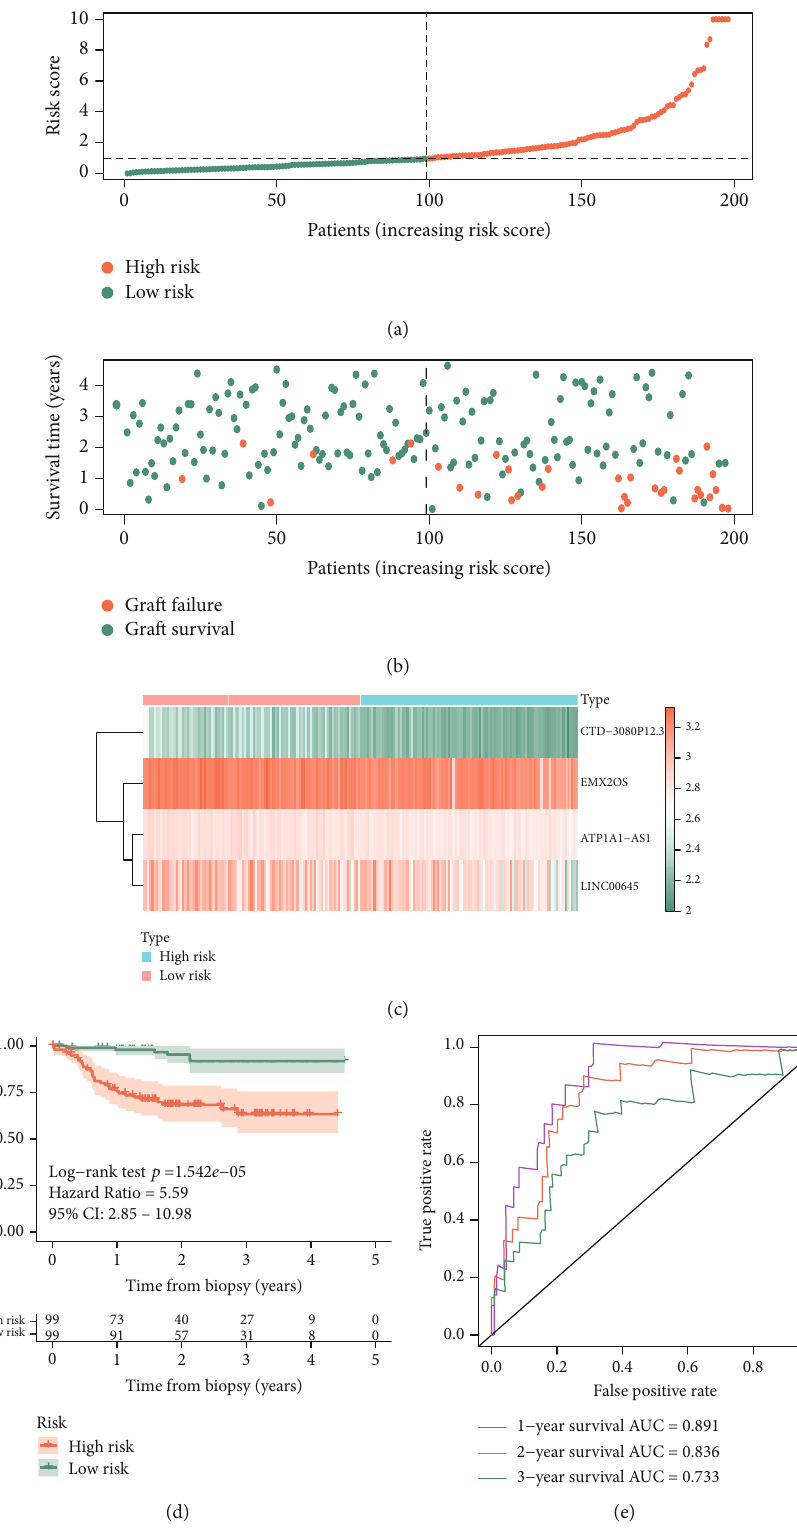
Figure 5: Prognostic analysis of the 4-lncRNA risk score in the training set of GSE21374 dataset. (a) The curve of risk score. The dotted line represents the cuto ff score which divides the patients into the low-risk group and high-risk group. (b) The survival status of renal allograft. The coral dots represent graft failure while the aquamarine dots represent graft survival. (c) Heat map of the 4-lncRNA expression pro fi les in the low-risk group and high-risk group. (d) KM survival analysis of the risk score model. (e) Time-dependent ROC analysis of the risk score model. KM: Kaplan-Meier; ROC: receiver operating